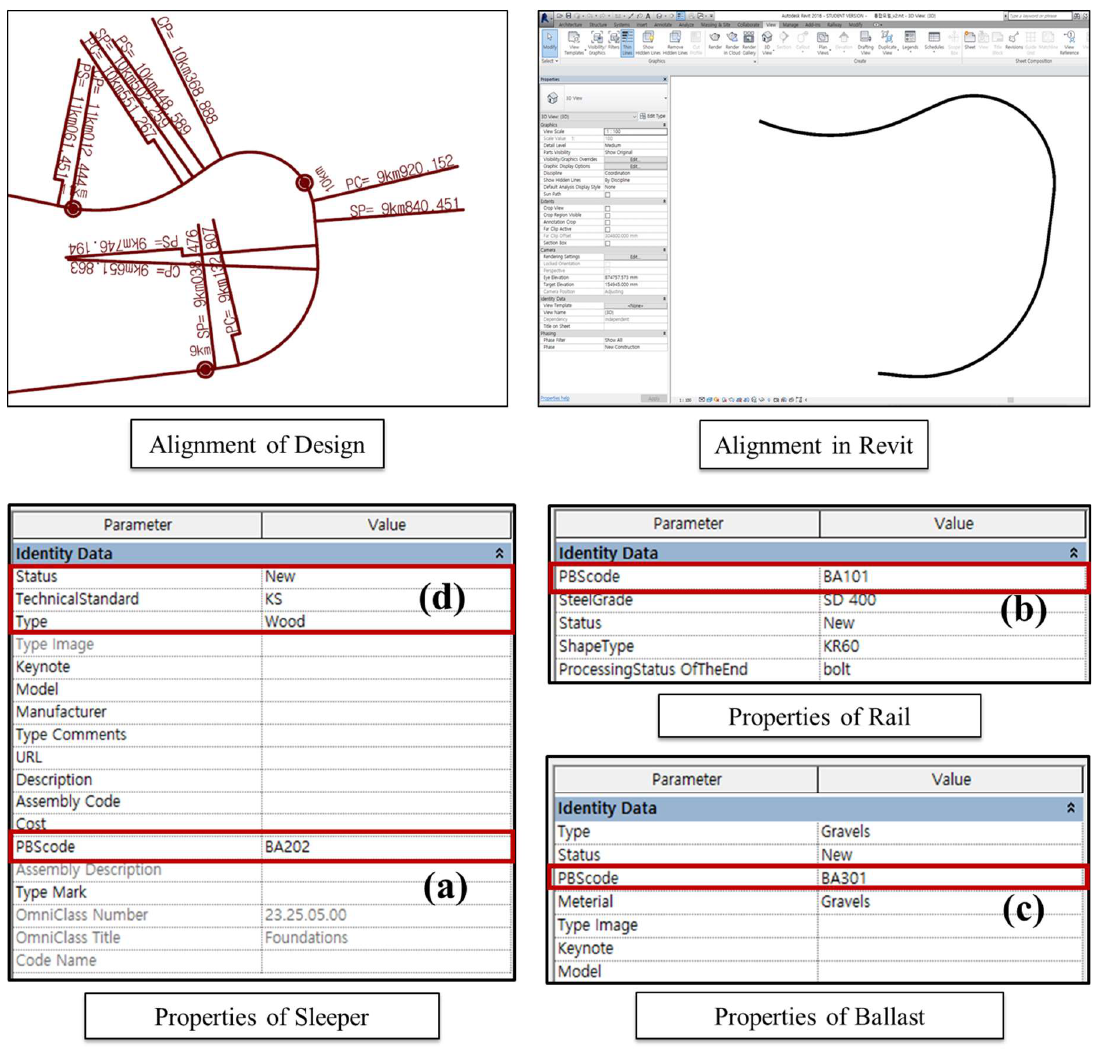
Figure 11. Railway track model in Autodesk Revit. ( a ) PBScode of sleeper; ( b ) PBScode of rail; ( c ) PBScode of ballast; and ( d ) An example of the information of sleeper.